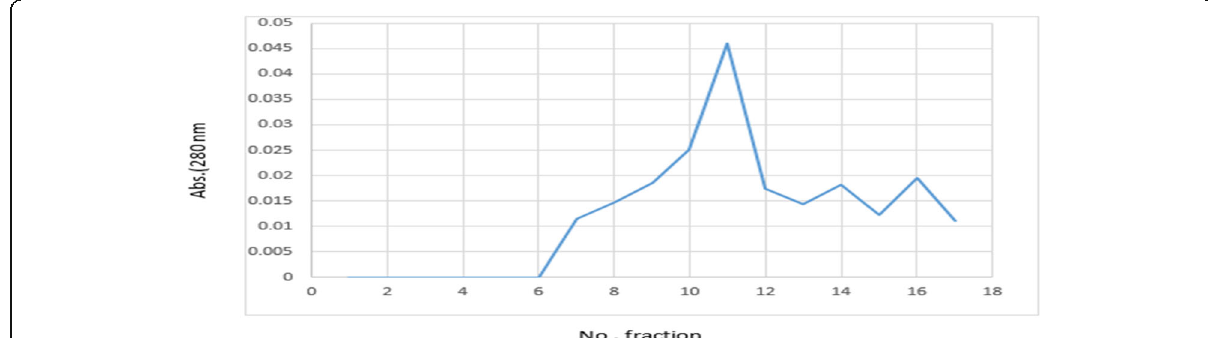
Fig. 1 Absorbance values of proteins content for purification killer toxin of Wickerhamomyces anomalus